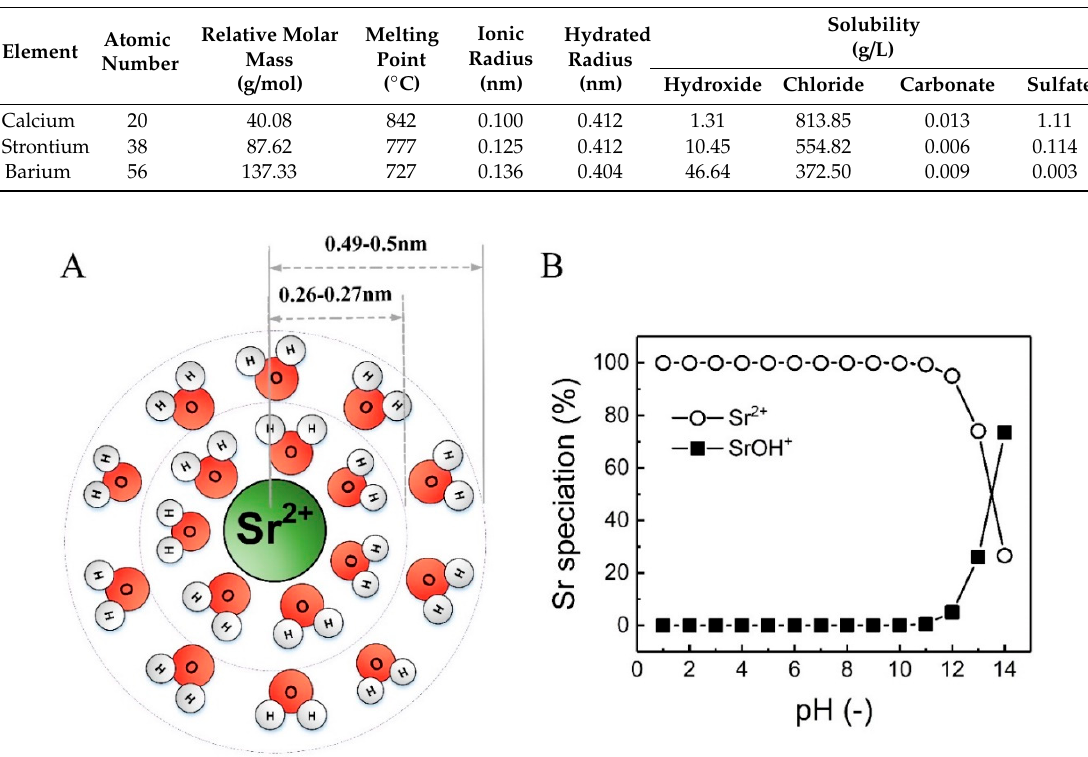
Figure 1. ( A ) Schematic of hydration shells around strontium (Sr 2 + ) ion. Inner and outer circles represent the first and second hydration shells; ( B ) basic speciation of strontium in water over a wide pH range (1–14) using Visual MINTEQ software (version 3.1, KTH, Sweden) (1 mg / L strontium chloride (SrCl 2 ), typical Sr concentration in surface water [10], 25 °C).